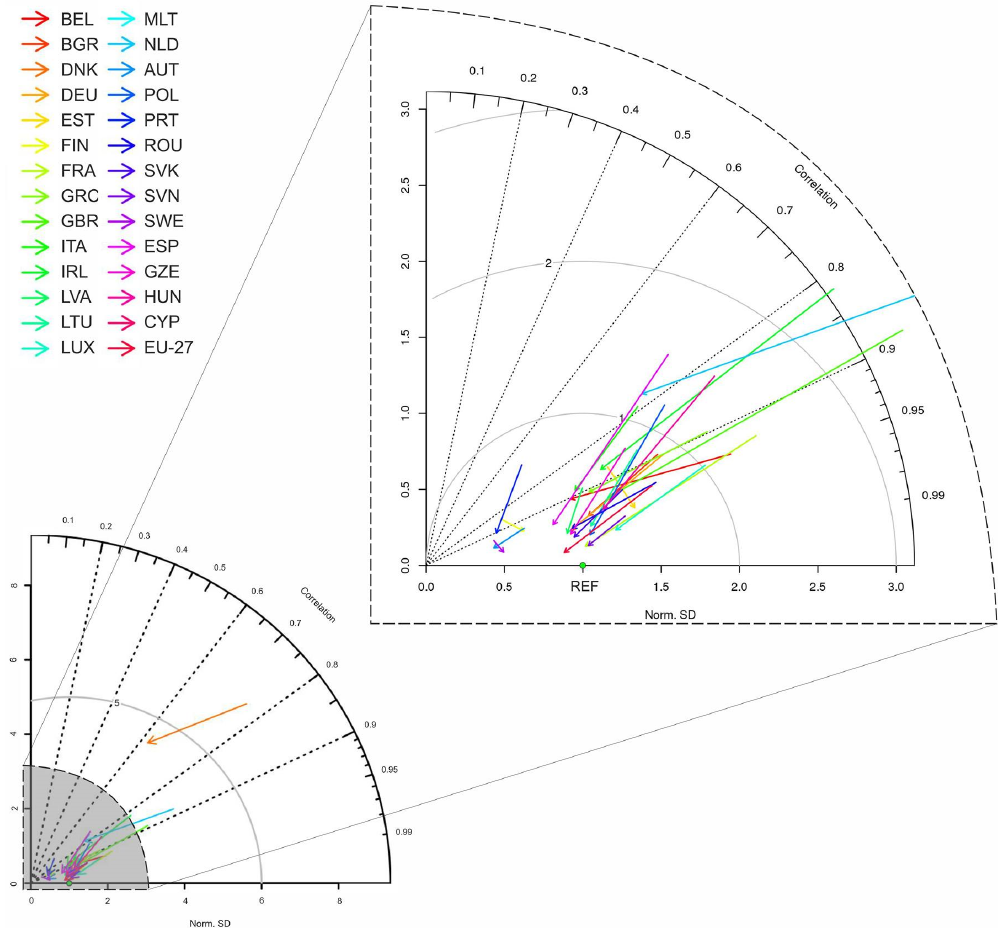
Figure 9. Overview of the model performance (S1 case) summarized in a Taylor diagram. Posterior and prior monthly- and country-scale aggregated biospheric fluxes are compared against the reference fluxes (true). Each line corresponds to a different country. The starting point of each arrow shows the prior and reference comparison and the ending point shows the posterior and reference comparison. Ideally the ending point should coincide with the green point, which represents the reference